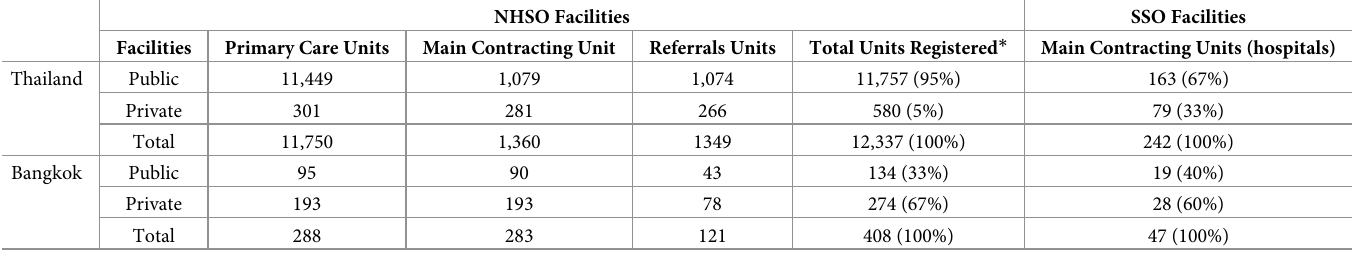
Table 4. Facilities contracted within the universal health coverage